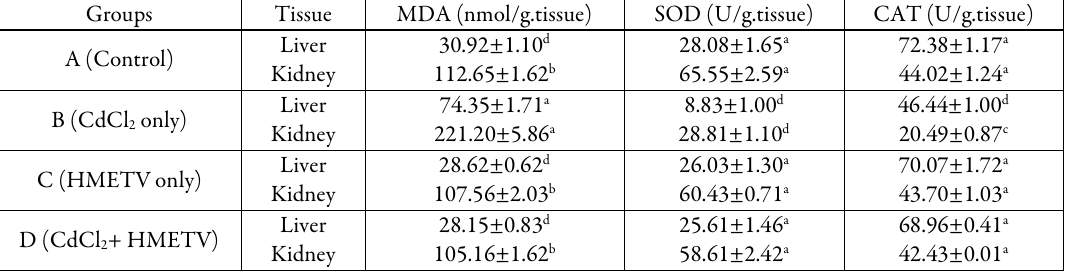
Table 2. Hepatic and renal oxidative stress marker and antioxidant enzyme activity of the experimental groups of rats